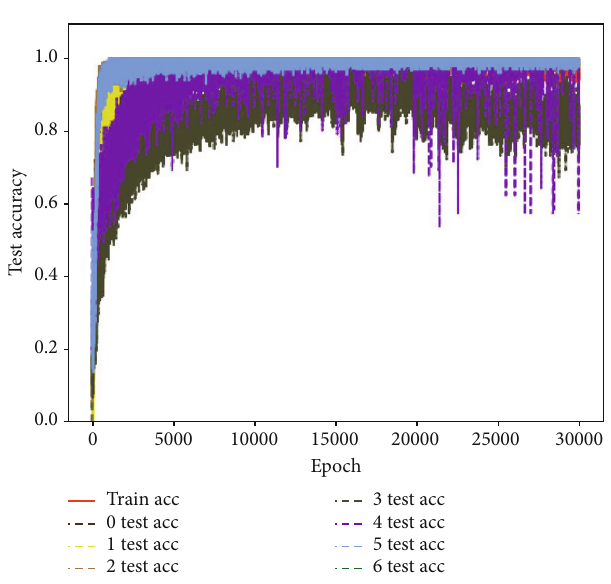
Figure 13: Accuracy rate curve of CNN.